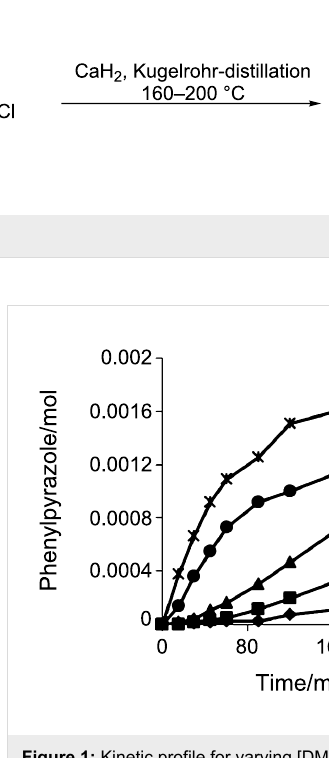
Figure 1: Kinetic profile for varying [DMDETA].